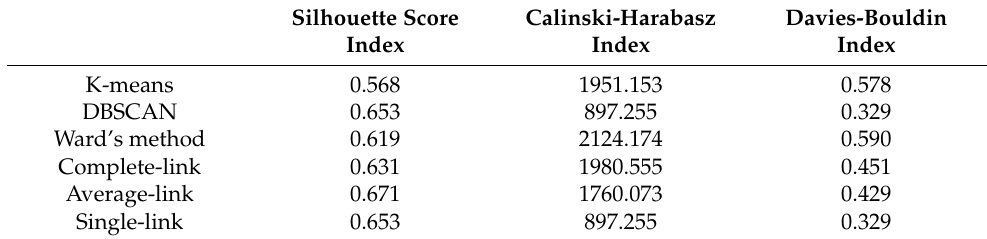
Table 2. Performance evaluation of clustering